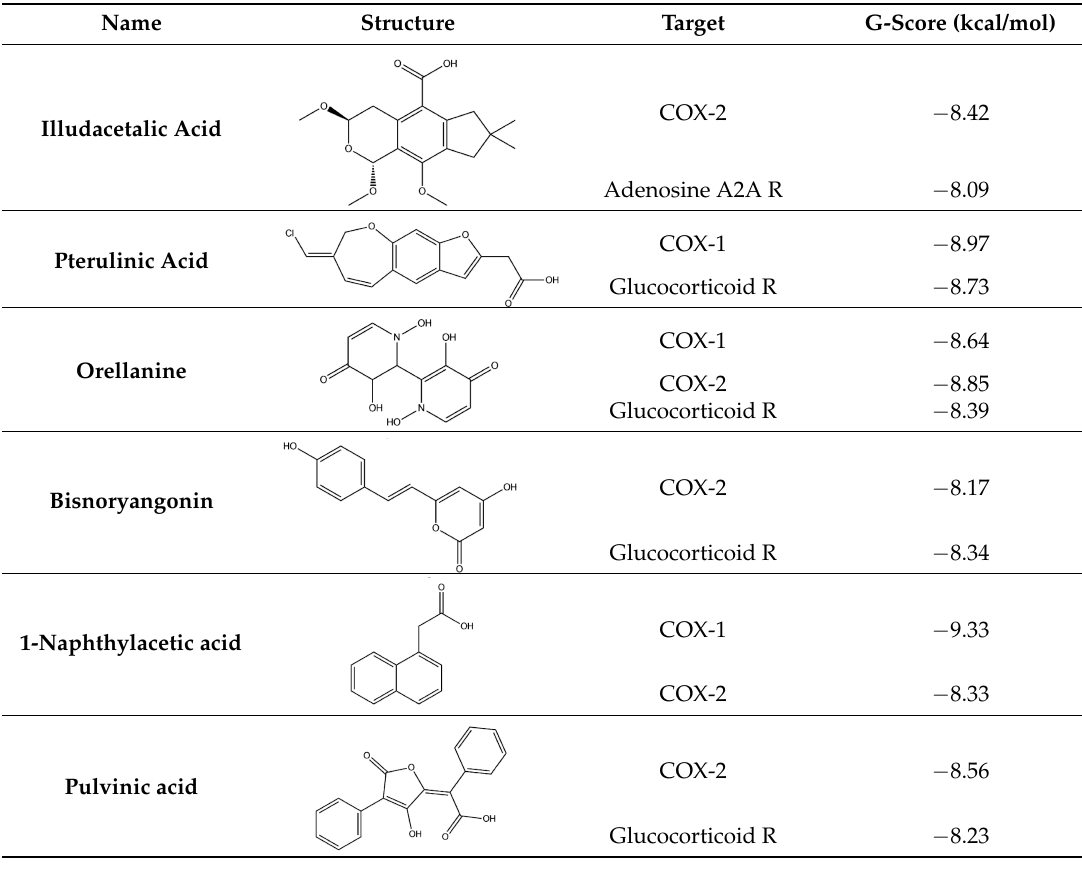
Figure 5. Molecular interactions of illudacetalic Acid and two anti-inflammatory targets: ( A ) Protein target, COX-2 (PDB: 5IKR). Protein is shown as a turquoise cartoon while ligand is shown as green carbon sticks; ( B ) Protein target, adenosine A2A receptor (PDB: 3RFM). Protein is shown as a dark blue cartoon while ligand is shown as yellow carbon sticks. H-bonds and π - π interactions are shown as dashed black and cyan lines respectively. Amino acid residues involved in the interactions are shown as gray sticks.